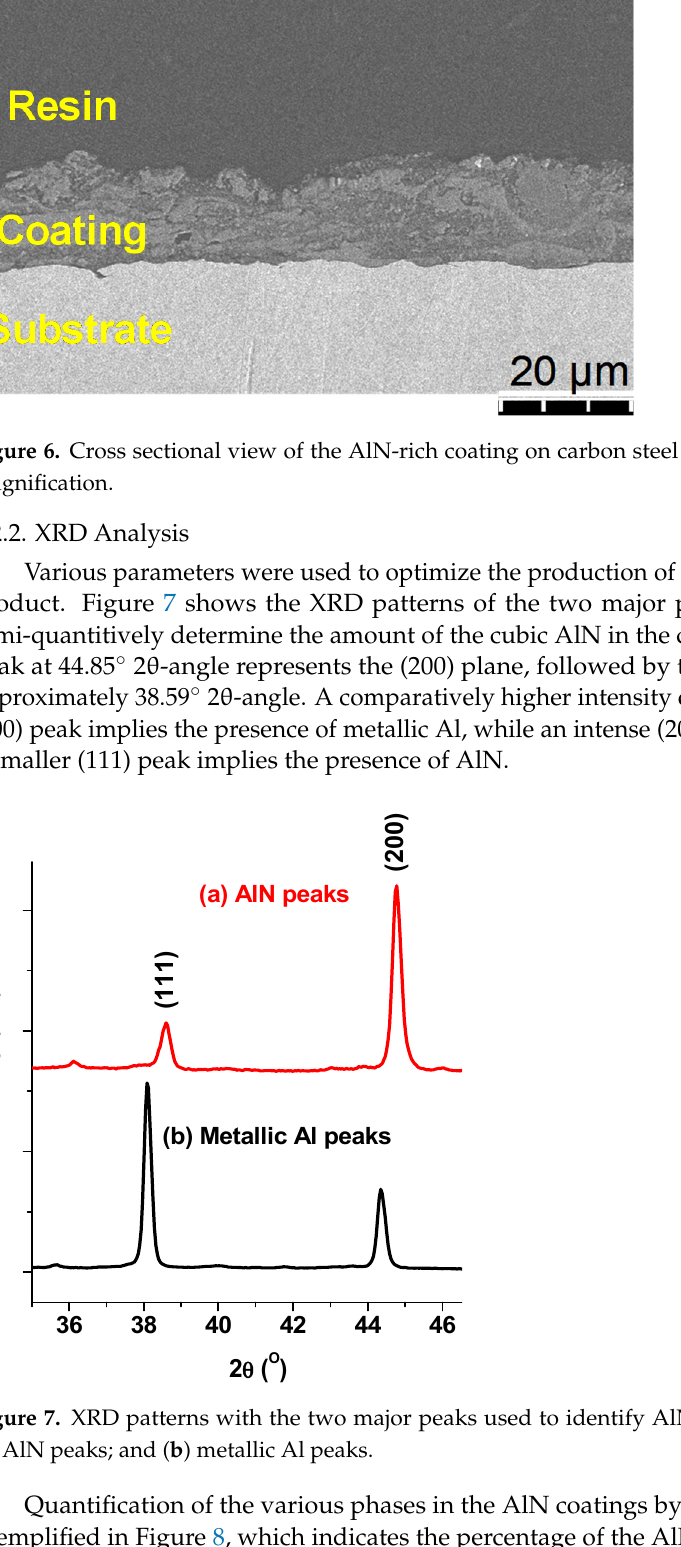
Figure 5. A top surface view by SEM imaging for plasma-synthesized AlN-rich coating on carbon steel in ×15,000 magnification.